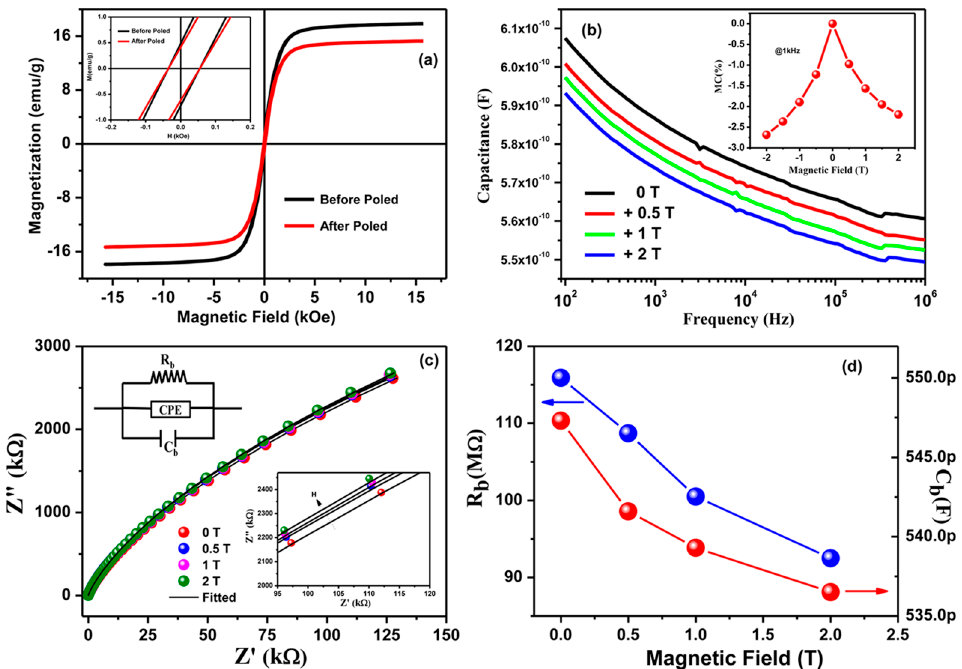
Figure 6. ( a ) Magnetic Field dependence of magnetization ( M ( H )) loops with and without electrical poling. ( b ) Capacitance as a function of frequency at different static H . ( c ) Z ’ (real part of impedance) vs. Z ’’ (imaginary part of impedance) plot at different H (solid line indicate the fitted data); the equivalent circuit used for fitting (inset). ( d ) Variation of bulk capacitance ( C b ) and bulk resistance ( R b ) at different H . Figure reproduced with permission from [22] .